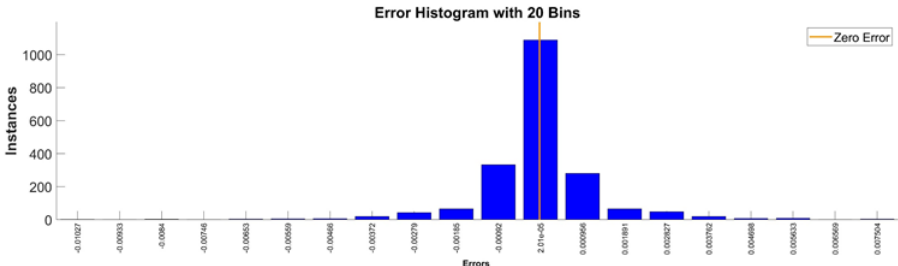
Figure 34. Error histogram between the target values and the estimated values for the workspace.